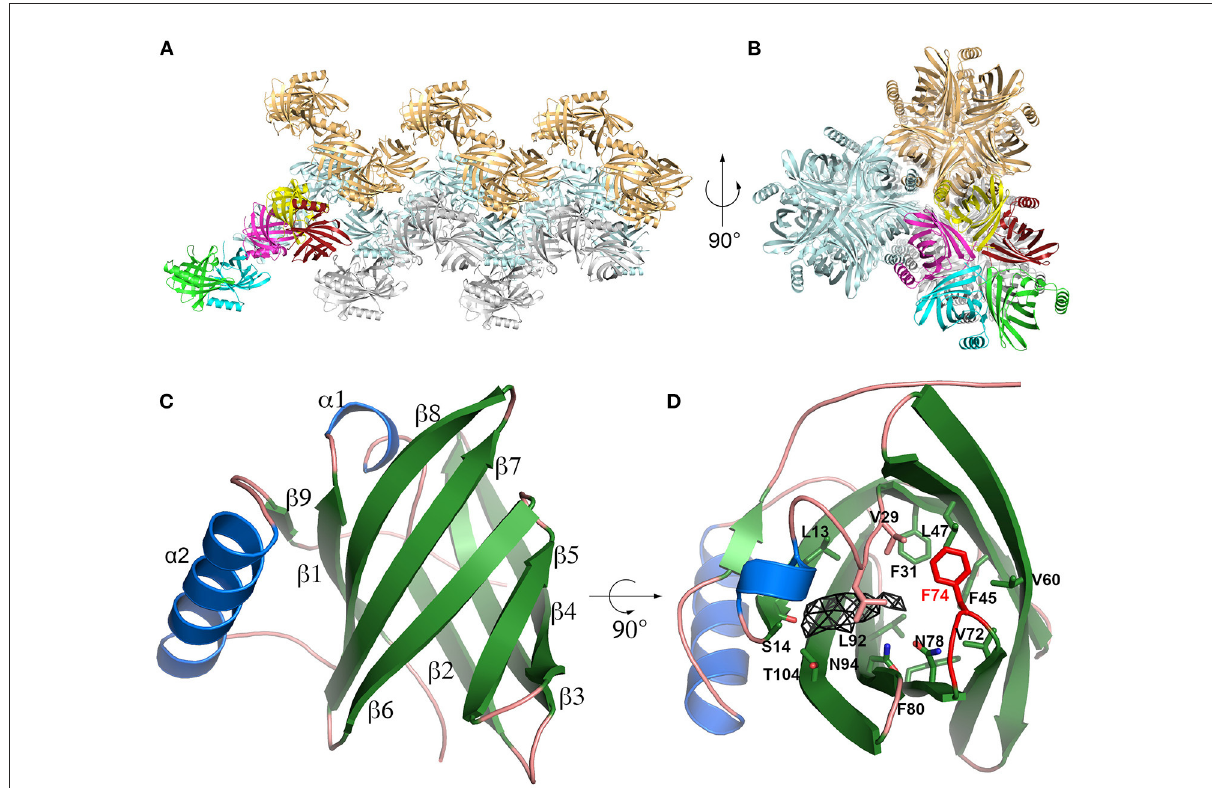
FIGURE2 Cav p 1.0101 crystal structure. (A,B) Cartoon representation of Cav p 1.0101 in two perpendicular orientations highlighting the stacking of helices observed in the crystal, with the five monomers of one asymmetric unit in bright colors. (C) Overall fold of Cav p 1.0101 with α -helix in blue and β -strands in green. (D) Same representation as (C) with residues defining the central cavity shown as sticks, the β 5 β 6 loop is in red, and the electron density (Fo-Fc map at 2 sigma level) observed in central cavity of monomer E as a black mesh.